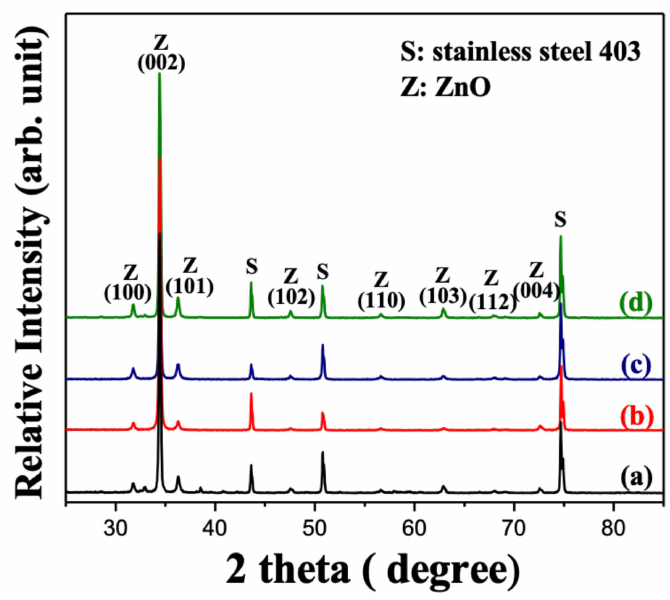
Figure 2. X-ray di ff raction (XRD) patterns of the ZnO nanorods deposited under growth condition of pH = 6 by chemical bath deposition at 70 ◦ C for ( a ) 3, ( b ) 4, ( c ) 5, and ( d ) 6